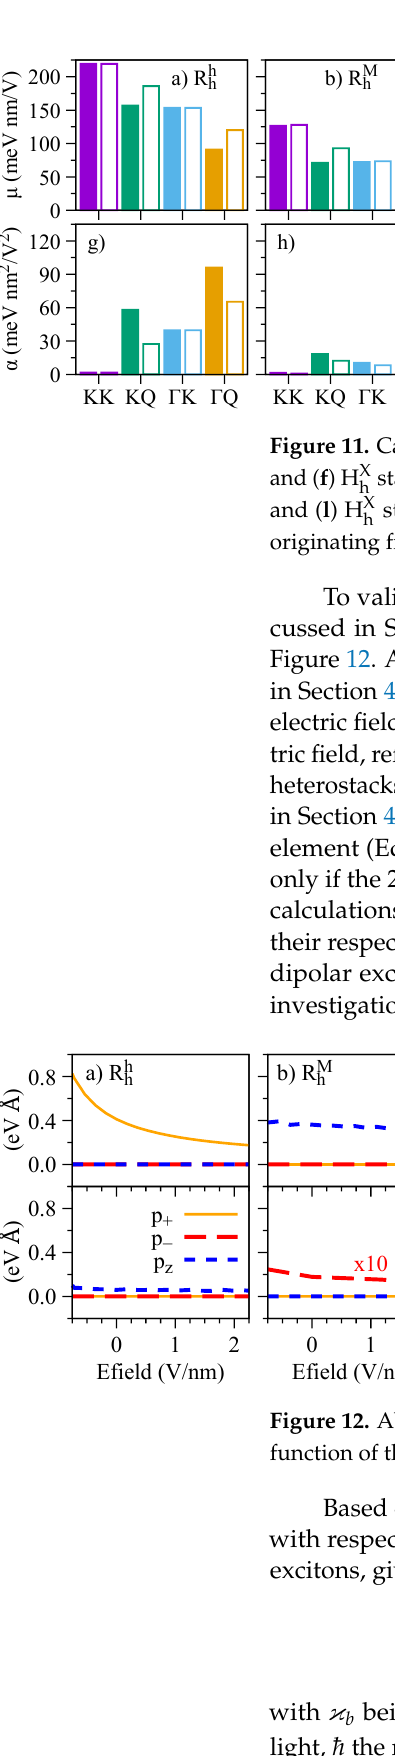
with κ b being the high-frequency dielectric constant of the environment, c the speed of light, ¯ h the reduced Plank constant, e the electron charge, E 0 the exciton energy, and | φ ( 0 ) |